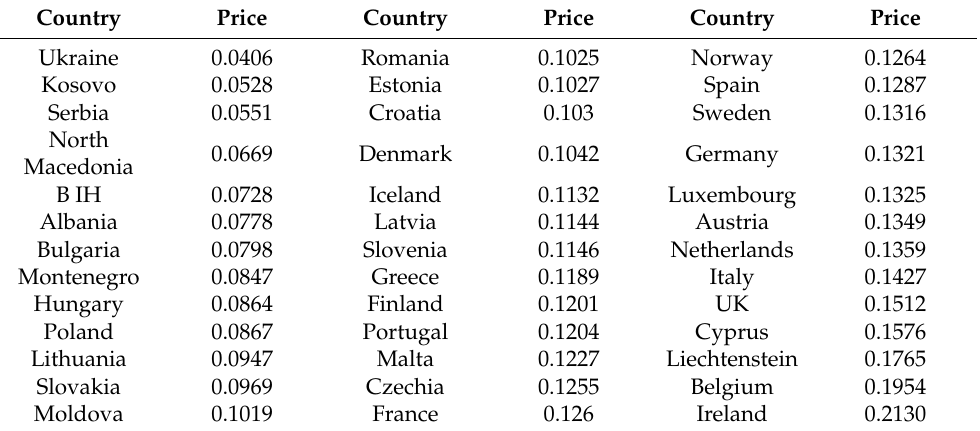
Table 5. Average electricity prices for household consumers in 2019 (in EUR per kWh, without taxes).